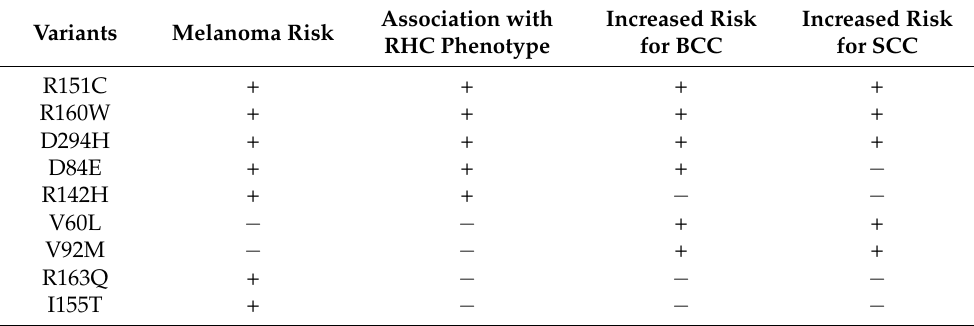
Table 3. Correlation between MC1R variants and melanoma risk, RHC phenotype and increased risk for BCC and SCC. Variants Melanoma